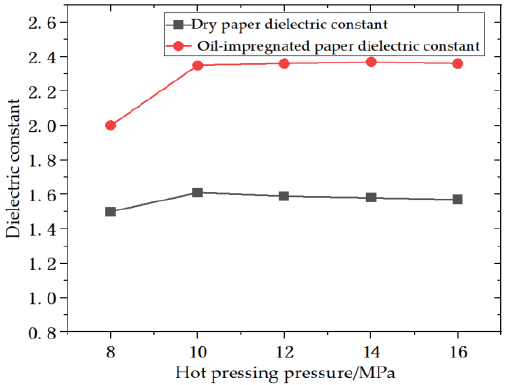
Figure 5. Dielectric constant of insulating paper with different hot pressing pressures.